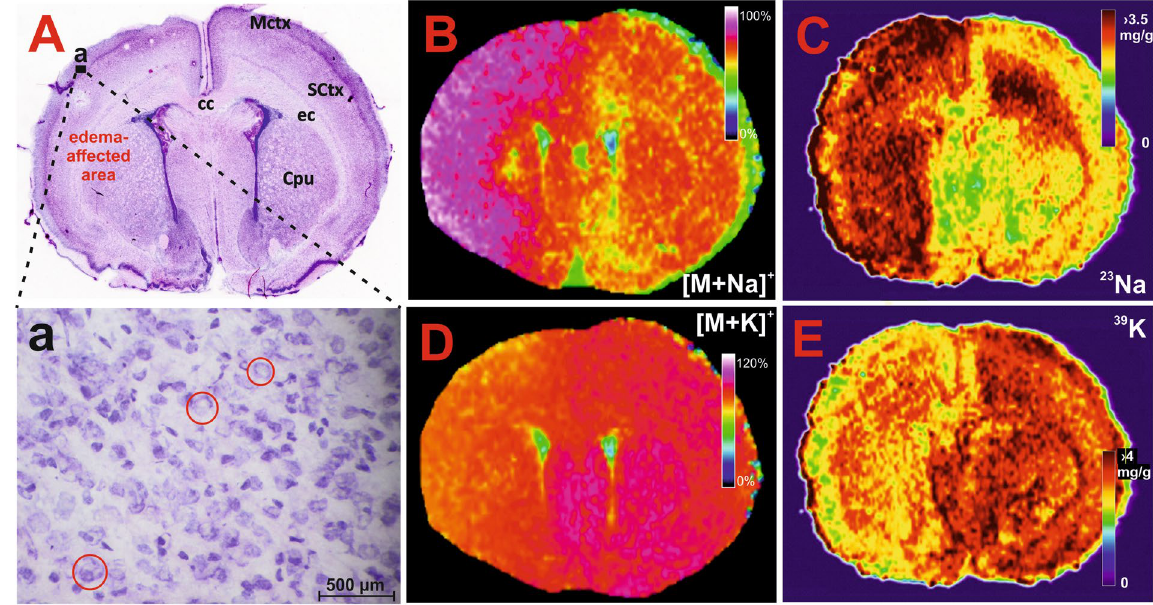
Figure 2. Histological and MSI assessment of the HI-insulted neonatal rat brains during the acute stage of HIE. Panel A: Haematoxylin-eosin stained section demonstrating the early cellular response; a – expanded region of the ipsilateral hemisphere (indicated by the black rectangle shown in (A)) depicting the cytotoxic oedema-afflicted neurons with signs of swelling and vacuolization (red circles). MALDI MS images showing the altered distribution of PC (16:0/16:0) in the sodiated (panel B, m/z 756.550) and potassiated (panel D, m/z 772.525; signal was overscaled to 120% to provide better contrast) form. Quantitative LA-ICP-MS images of the elemental sodium (panel C) and potassium (panel E) distribution (for details see Supplementary Figure S4). MCtx (motor cortex), cc (corpus callosum), SCtx (somatosensory cortex), ec (external capsule), Cpu (caudate putamen = striatum). Different image scaling (B/D versus C/E) are due to different FlexImaging (Bruker Daltonics, Bremen, Germany) and ImageLab 42